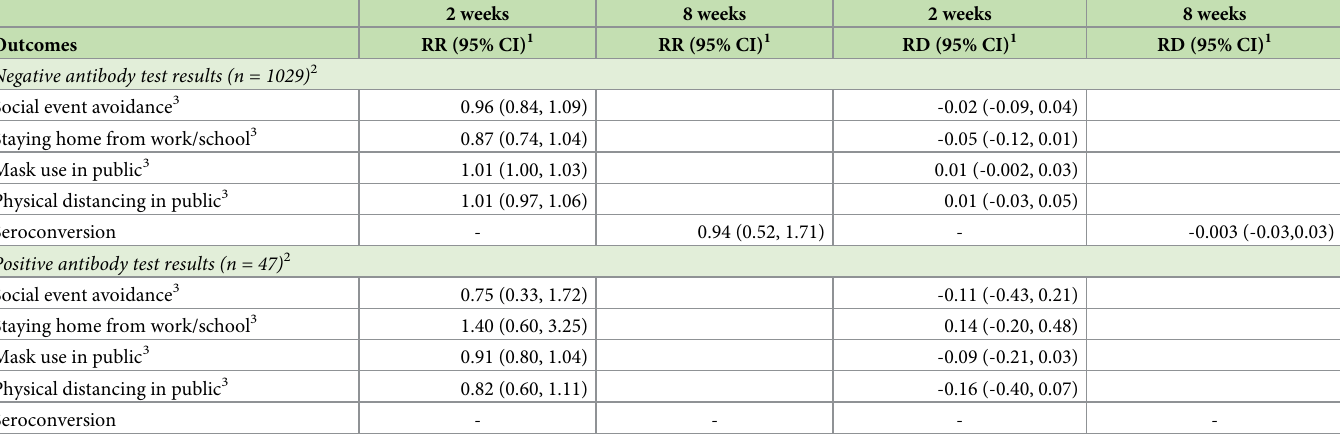
Table 2. Associations between treatment condition (immediate vs delayed antibody test results) and key behavioral and biological outcomes, stratified by baseline antibody